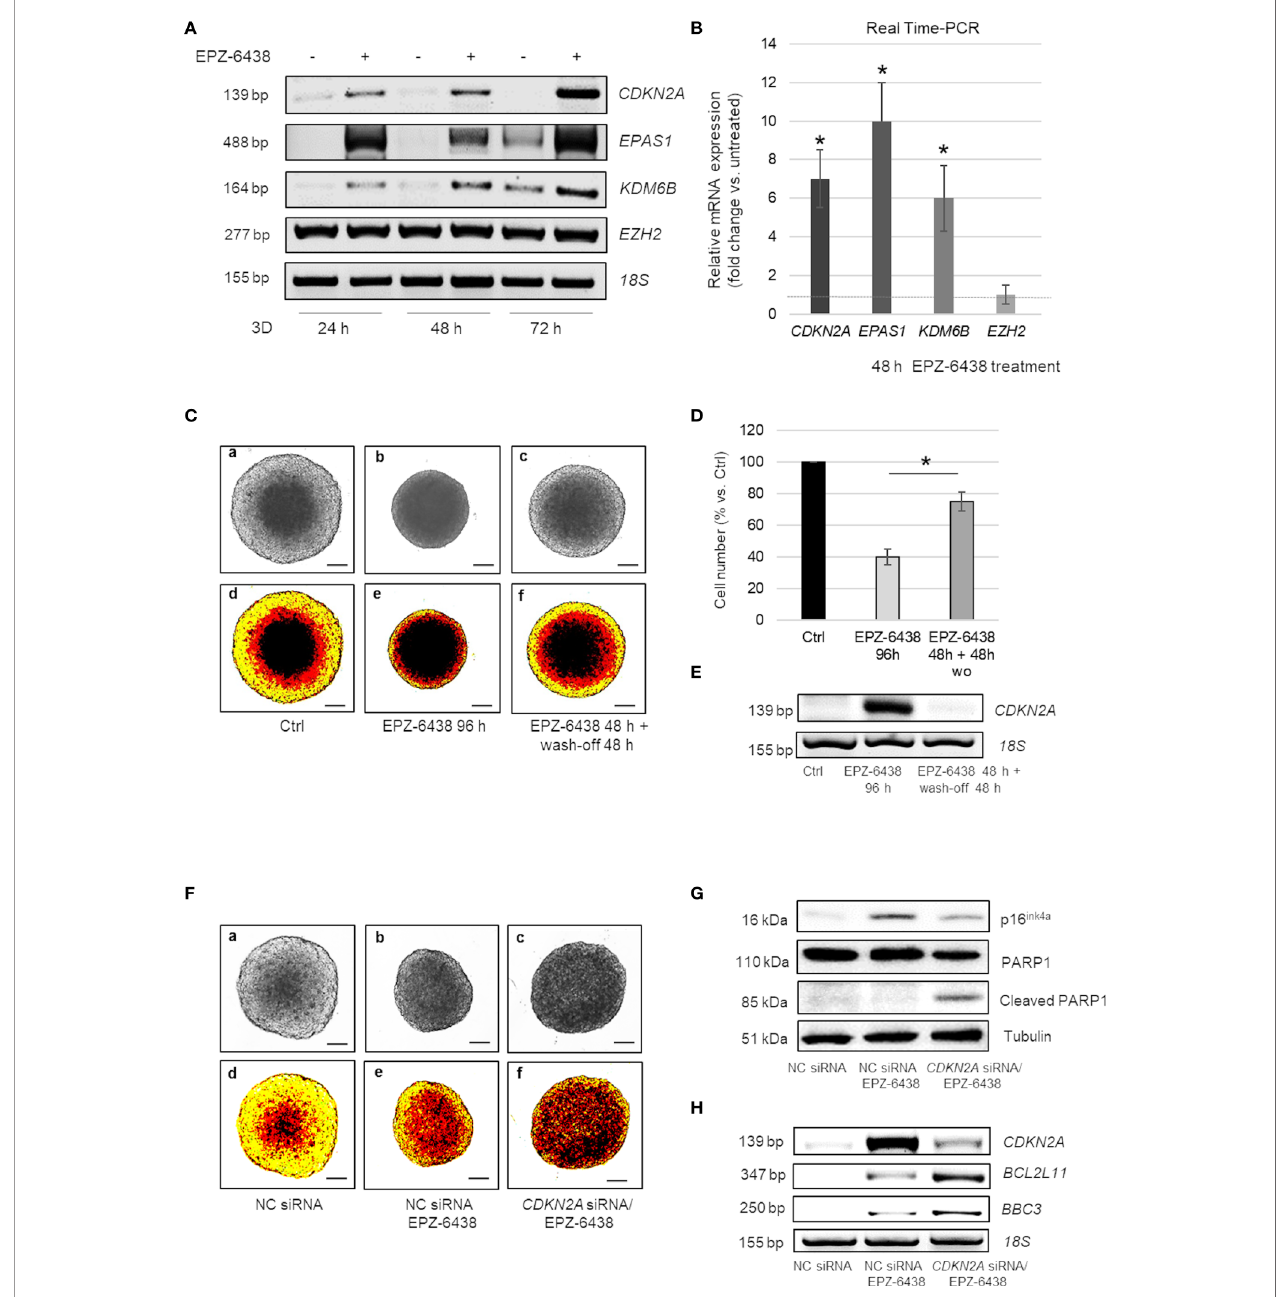
FIGURE 4 | EZH2 inhibition induces cell cycle arrest in CDKN2A + or apoptosis in CDKN2A - MPM MCS (A) Representative RT-PCR analysis of CDKN2A, EPAS1, KDM6B and EZH2 in MSTO-211H MCS treated or not 24, 48 and 72 h with EPZ-6438. (B) CDKN2A, EPAS1, KDM6B and EZH2 mRNA expression (fold increase over Ctrl) after 48 h treatment with EPZ-6438 of MSTO-211H MCS con fi rmed by Real time PCR (qPCR). 18S rRNA was used as housekeeping gene. (C) Representative phase contrast images (×40 magni fi cation) (a – c) and relative pseudo-color images (d – f) of MSTO-211H MCS treated ± EPZ-6438 for 96 h or treated for 48 h with EPZ-6438 and, after wash-off, grown for additional 48 h in normal medium. (D) Bar graph shows the percentage of viability of MSTO-211H MCS treated 96 h with EPZ-6438 or treated for 48 h with EPZ-6438 and, after wash-off, grown for additional 48 h in normal medium. Each bar represents mean of three independent experiments ± s.d., *p ≤ 0.05. (E) Representative quantitative RT-PCR analysis of CDKN2A in MSTO-211H MCS treated as described above. 18S rRNA was used as housekeeping gene. (F) Representative phase contrast images (×40 magni fi cation) (one of 12) (a – c) and relative pseudo-color images (d – f) of MSTO-211H MCS transfected with negative control (NC) siRNAs or CDKN2A speci fi c siRNAs ( CDKN2A siRNA) and treated ± EPZ-6438, 48 h. Scale bar = 100 m M. (G) Representative Western blot analysis of p16 ink4a , PARP1 and cleaved PARP1 in MSTO-211H MCS transfected with negative control (NC) siRNAs or CDKN2A speci fi c siRNAs ( CDKN2A siRNA) and treated with or without EPZ-6438 for 48 h. Tubulin was used as loading control. (H) Representative RT-PCR analyses of CDKN2A , BCL2L11 and BBC3 in MSTO-211H MCS transfected with negative control (NC) siRNAs or CDKN2A speci fi c siRNAs ( CDKN2A siRNA) and treated, 48 h, with EPZ-6438. 18S rRNA was used as housekeeping